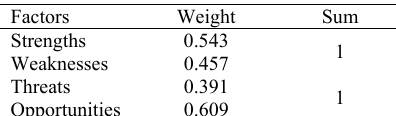
Table 4: IFEM and EFEM Total weight